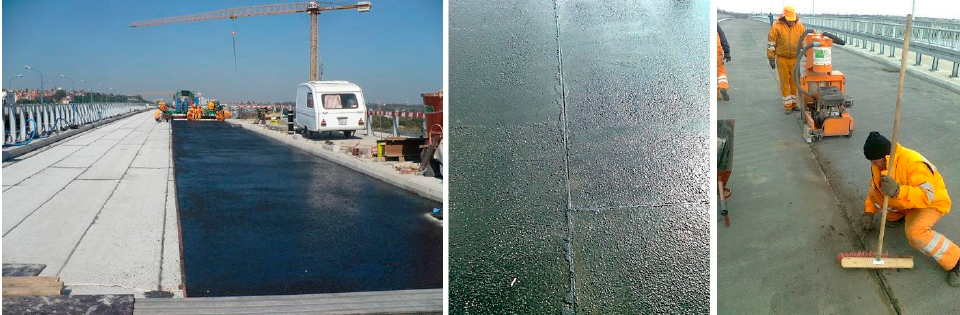
Figure 3. Longitudinal joints in a mastic asphalt pavement constructed in stages [33].